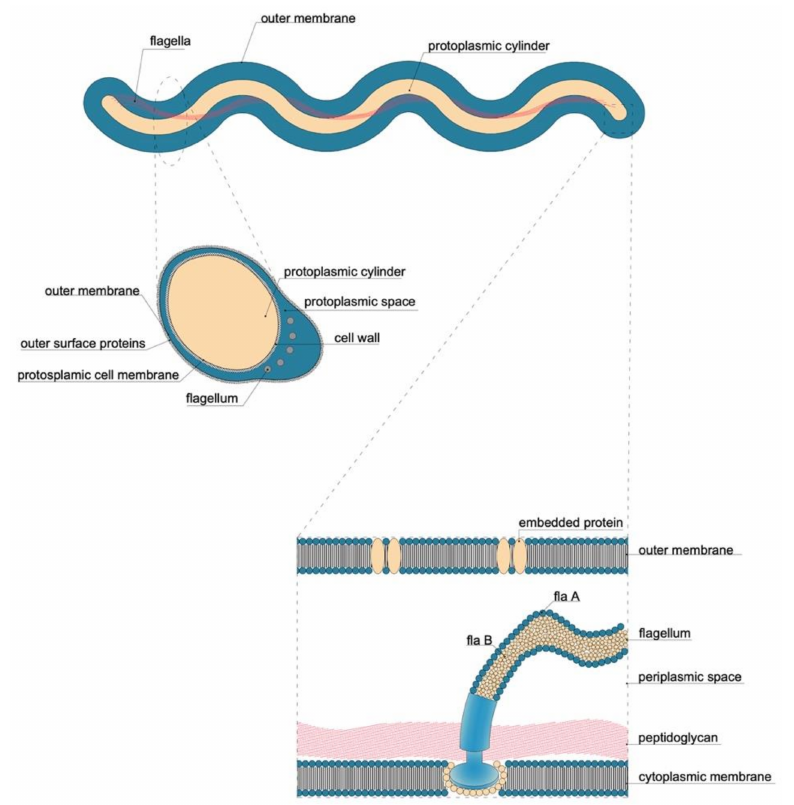
Figure 5. Representation of the Borrelia Lyme group structure (image by P. Forgione). When viewed using an electron microscope, the typical spiral shape is visible (Figures 4 and 6), sharing the characteristics of spirochetes, such as the small thickness, the spiral morphology, the presence of endoflagella and the extreme lability to environmental factors; however, it is distinguished from the other spirochetes for the features described in Table 5 [145].